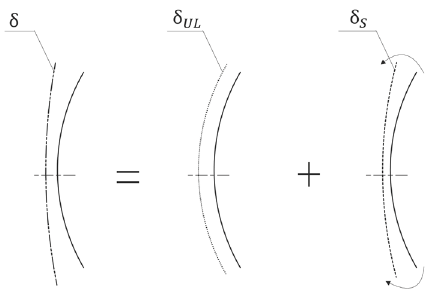
Figure 1. Illustration of surface deformation due to temperature variation.